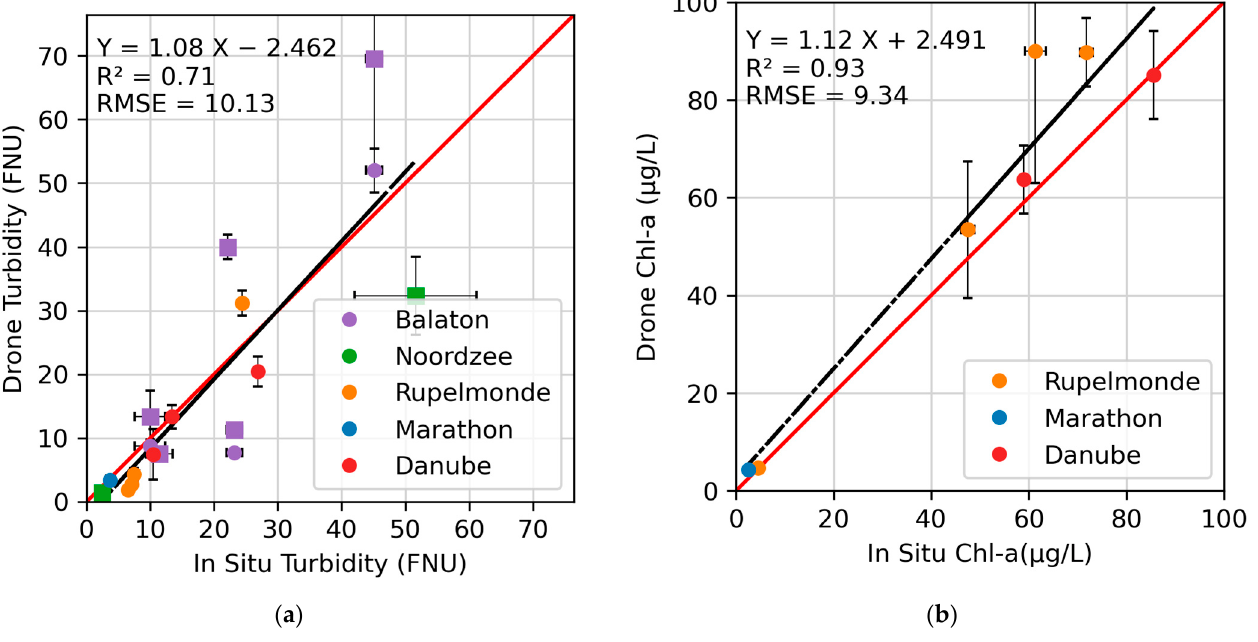
Figure 5. Scatterplot of drone-derived versus in situ measured observations. ( a ) turbidity plot (circles are derived from MSREM, squares are derived from DJI PH4), ( b ) Chl-a plot (derived from MSDUAL). Red line = 1:1 line, black line = regression line. Table 3. Regression statistics of turbidity products when DJI PH4 and MSREM are combined and for both sensors separate.